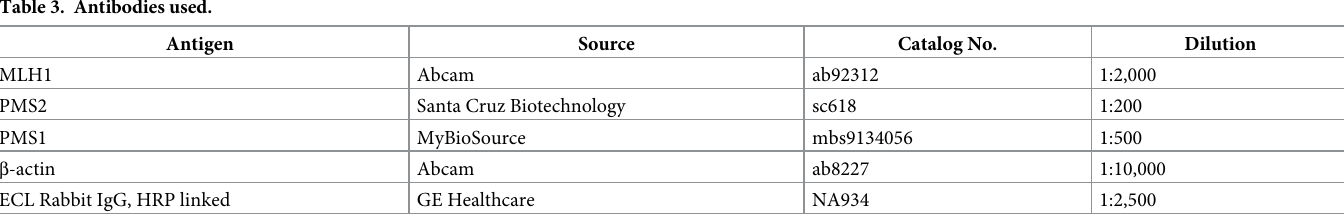
Table 3. Antibodies used.